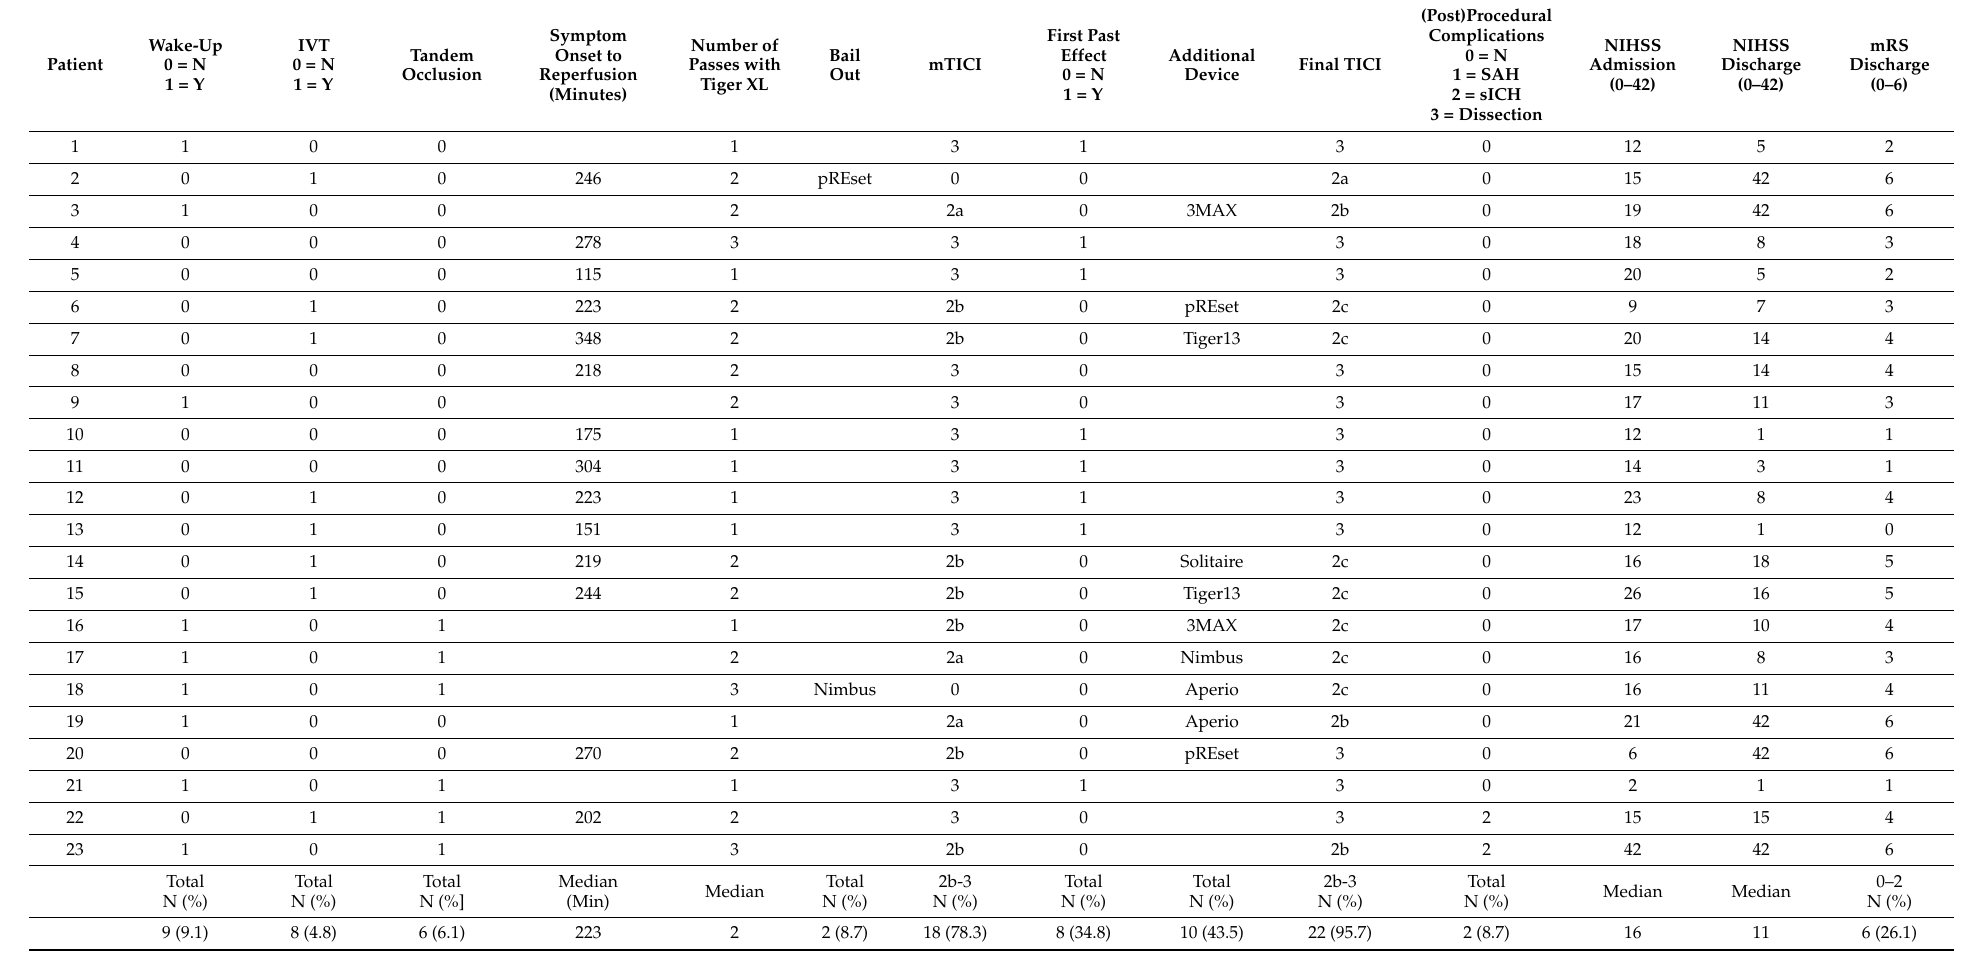
Table 1. Summarizes baseline clinical and angiographic results of all cases treated using the Tigertriever XL Device due to an acute occlusion of the ICA